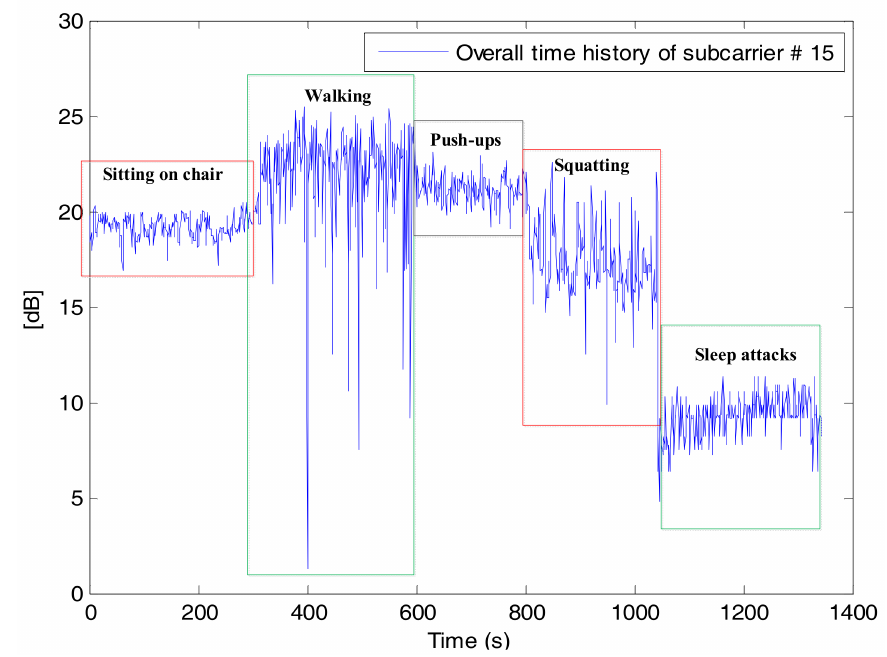
Figure 4. Time history of person’s five different